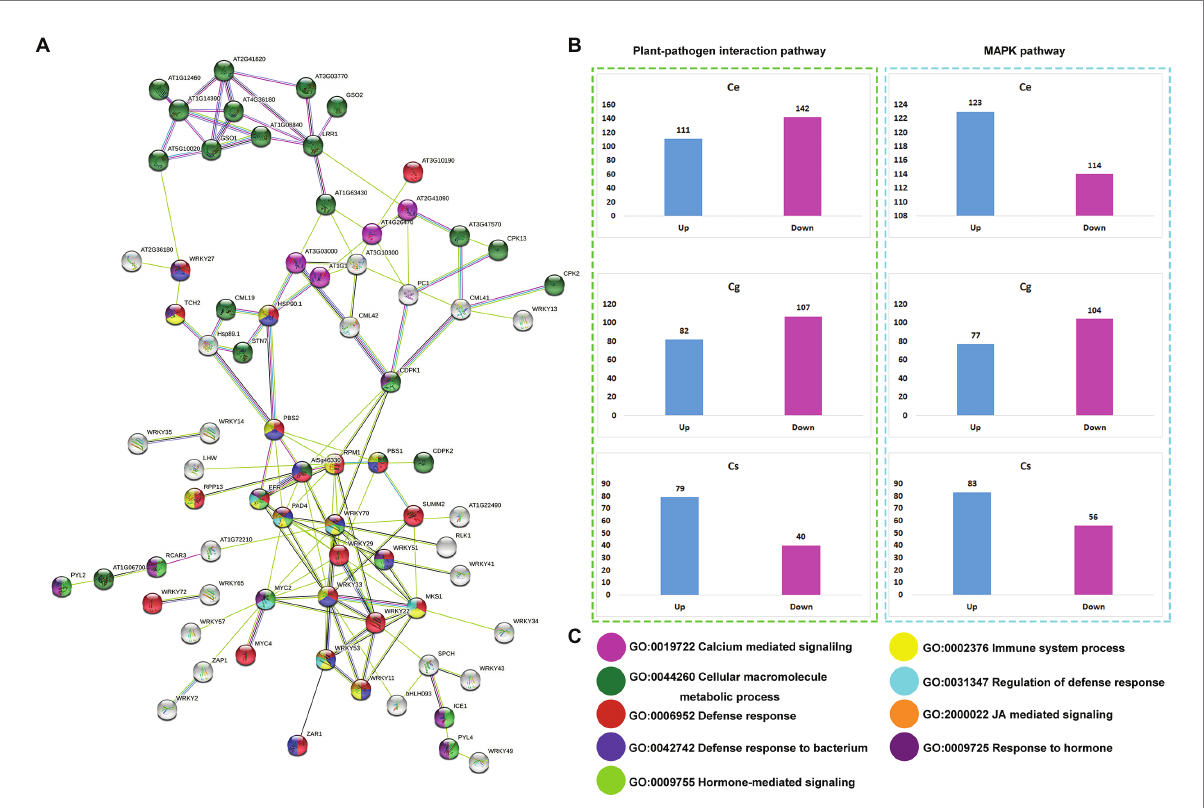
FIGURE 6 Identification string-based interaction network for all the genes expressed in three orchid species (A) , up- and downregulated genes for plant- pathogen interaction pathway and MAPK signaling pathway for three orchid species (B) , and the representation of major biological process enriched in the interaction network (C)